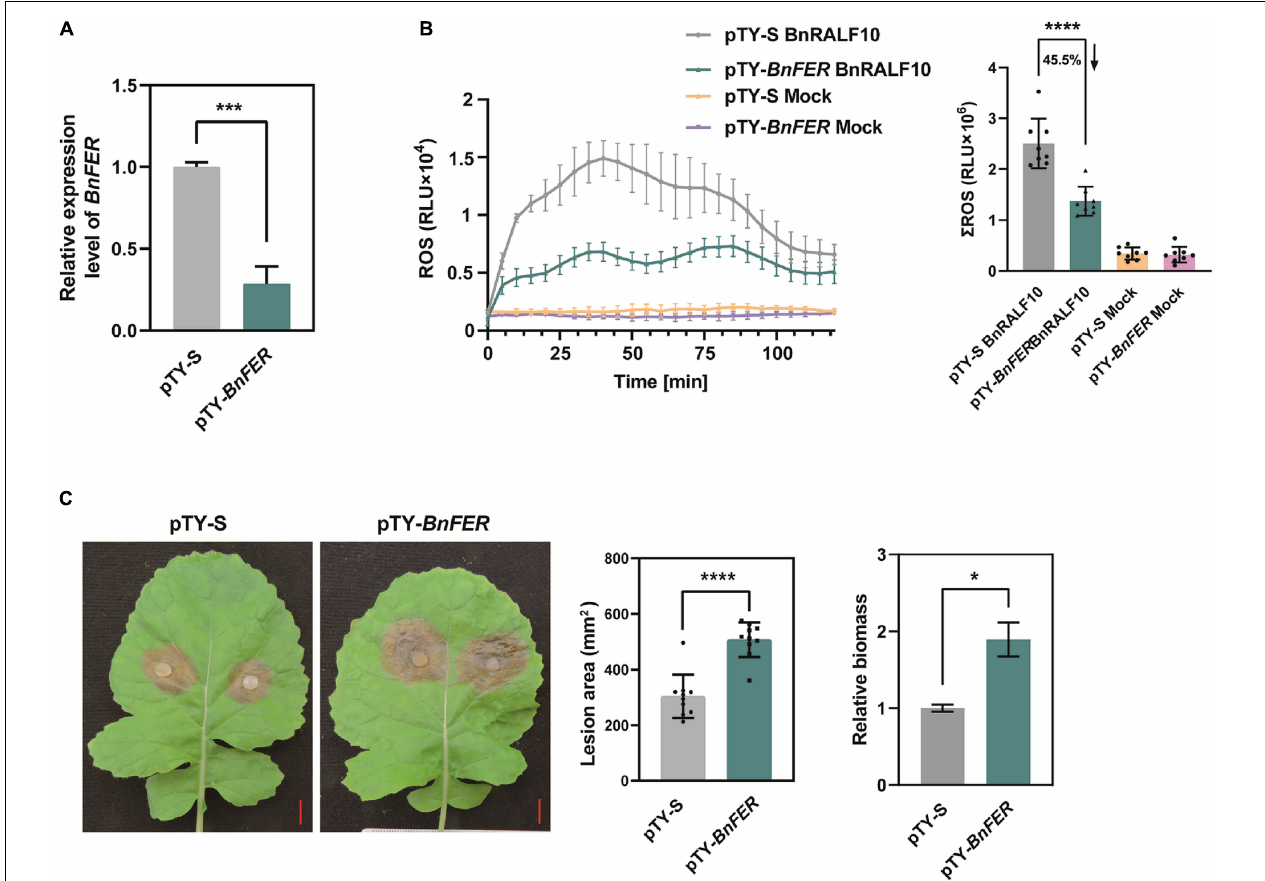
FIGURE 8 | BnFER was required for BnRALF10 to function. (A) Efficient silencing of BnFER by pTY- BnFER treatment in rape leaves as manifested by the vastly reduced level of BnFER transcript, which was detected by qRT-PCR analysis using B. napus actin ( BnActin7 ) as reference gene. Data are shown as the mean ± SE ( n = 7, *** P ≤ 0.001, Student’s t -test). (B) Effect of BnFER -silencing on BnRALF10-induced ROS burst. ROS measured in rape leaf disks of BnFER -silenced and control plants after addition with 1 µ M BnRALF10 peptide or water (mock). Shown are the dynamics of ROS production (left) and the integration (right) as mean values of total photon counts over 120 min. Data are shown as the mean ± SE ( n = 8, ∗∗∗∗ P ≤ 0.0001, Student’s t -test). (C) Effect of BnFER -silencing on BnRALF10-induced resistance to S. sclerotiorum . Leaves of BnFER -silenced and control plants were inoculated with S. sclerotiorum . Disease symptoms (left), lesion area (middle) and fungal biomass in inoculated leaves (right) at 24 hpi were shown. Data are shown as the mean ± SE ( n = 7, ∗ P ≤ 0.05, ∗∗∗∗ P ≤ 0.0001, Student’s t